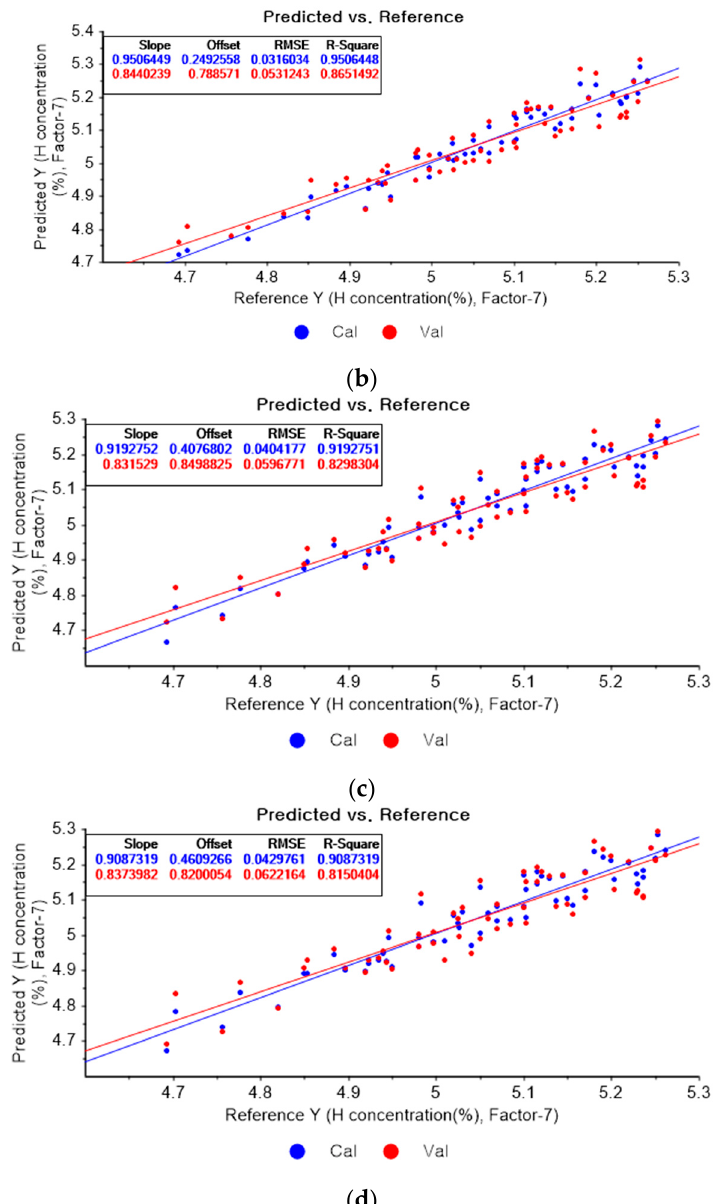
Figure 8. PLSR model of hydrogen concentration with ( a ) original data and PLSR models pre-processed by SG derivative using ( b ) second-order derivative and second-order polynomial with one point, ( c ) second-order derivative and second-order polynomial with three points, and ( d ) second-order derivative and second-order polynomial with five points.